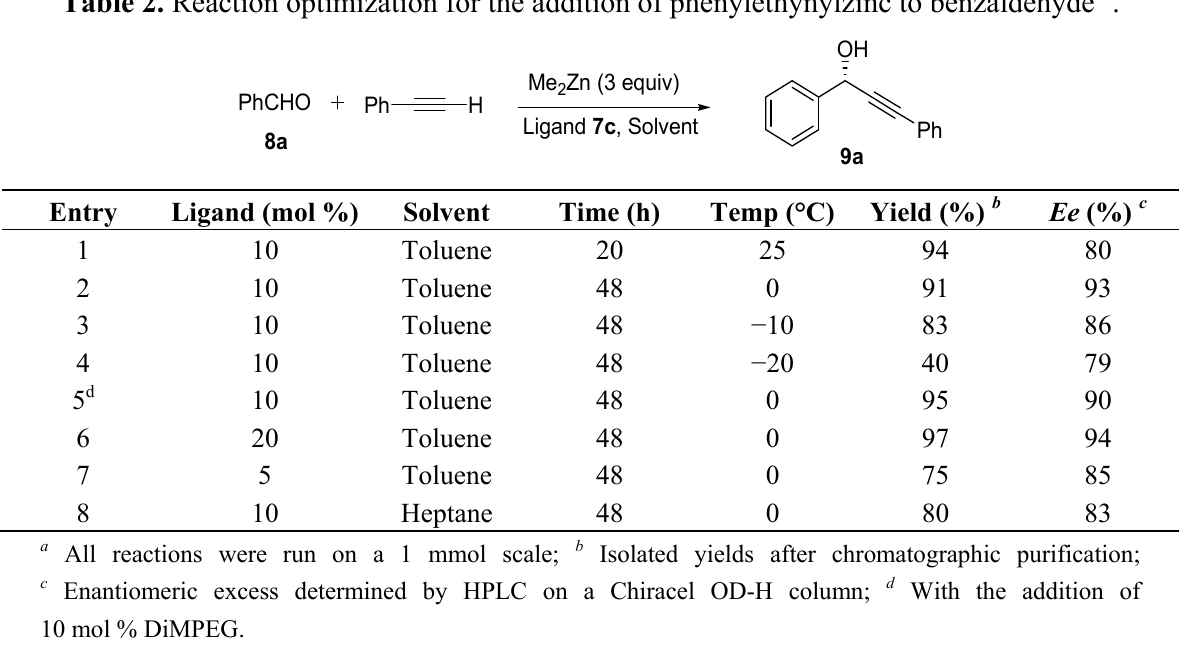
Table 2. Reaction optimization for the addition of phenylethynylzinc to benzaldehyde a .